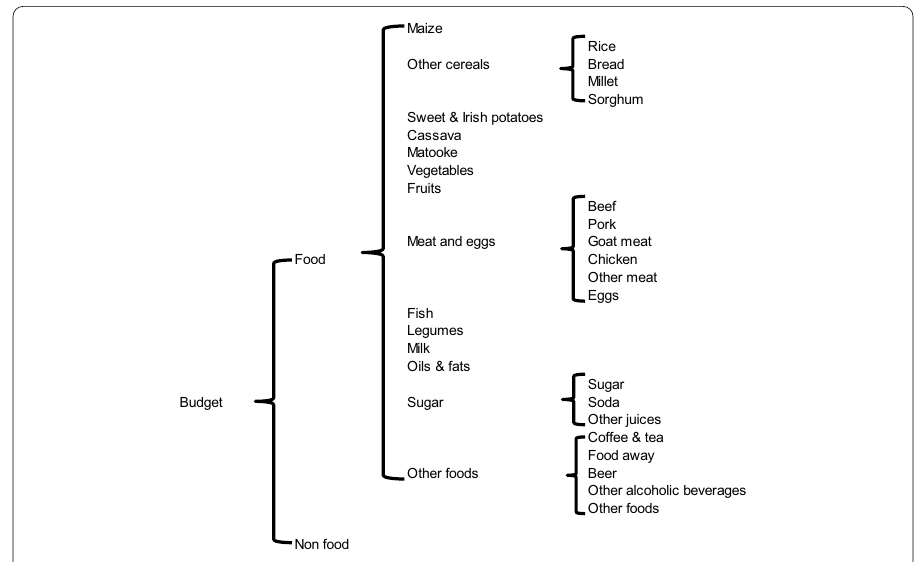
Fig. 2 Uganda augmented demand system. Source : Based on Boysen